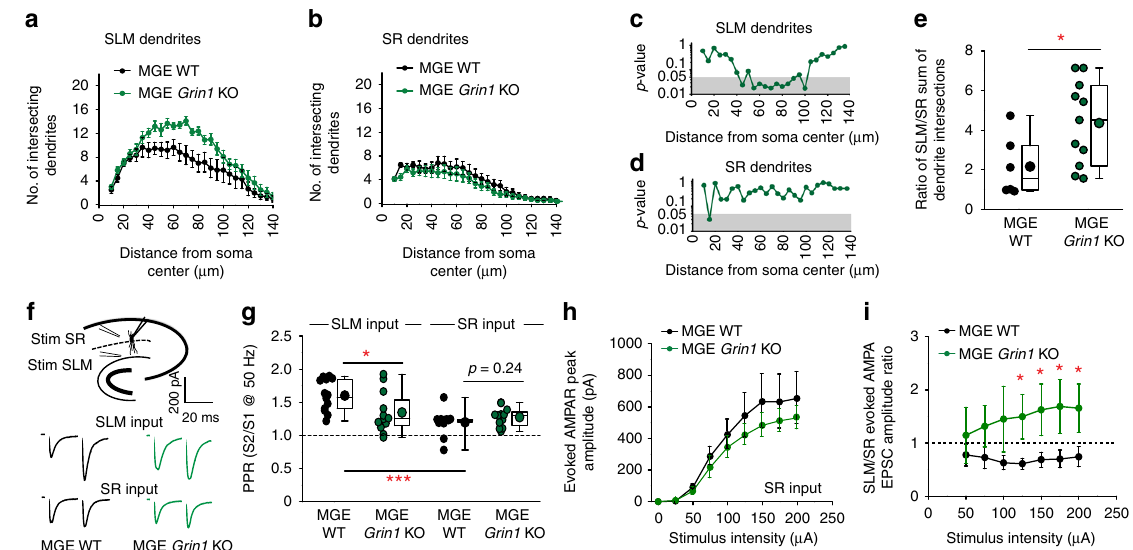
S t i m u l u s i n t en s i t y ( µ A ) Fig. 7 NMDAR hypofunction shifts the relative contributions of AMPA receptor mediated excitatory drive at extra- vs. intra-hippocampal inputs onto individual NGFCs. a , b Sholl analyses plots of total number of intersecting dendrites at each concentric circle (0 – 135 μ m from center of soma every 5 μ m) in WT (black data; n = 6) and Grin1 KO mice ( green data , n = 11) for SLM and SR dendrites in individual MGE NGFCs. Note these data are reanalyzed from the total dendrite Sholl analyses depicted in Fig. 5g. c , d Statistical comparison of the number of intersecting NGFC dendrites at each concentric distance away from the cell soma in WT vs. Grin1 KO mice ( p -values are derived from Mann – Whitney U test). Shaded gray areas denote p < 0.05. ( e ) Ratio of the sum of SLM vs. SR intersecting dendrites (between 40 – 100 μ m away from soma center) in each individual MGE NGFC analyzed in WT ( black circles ; n = 5) and Grin1 KO ( green circles ; n = 11). ( f ) Top panel ; schematic depicting the recording con fi guration and stimulus (stim) electrode arrangement to evoke AMPAR- mediated synaptic input mediated by SR and SLM afferents onto the same NGFC. Bottom panel ; single trace examples of paired pulse ratio (PPR) at 50 Hz of SLM and SR inputs onto an individual NGFC in WT ( black traces ) and Grin1 KO ( green traces ) mice. ( g ) Pooled data of PPR in P16-21 WT ( black circles ; n = 13, 12 for SLM and SR input, respectively) and Grin1 KO mice ( green circles ; n = 12, 11 for SLM and SR input, respectively). ( h ) Relationship curves of SR evoked AMPAR-mediated EPSC amplitude vs. stimulus strength onto MGE NGFCs in WT ( black data ; n = 6) and Grin1 KO mice ( green data ; n = 7). ( i ) Ratio of the SLM vs. SR evoked maximal AMPAR-mediated EPSC amplitude vs. stimulus strength onto individual MGE NGFCs in WT ( black data ; n = 6) and Grin1 KO mice ( green data ; n = 7). Mann – Whitney U -tests were used for all comparisons (** p < 0.01, *** p < 0.001). All n values correspond to the number of cells recorded. Construction of box-whisker plots is detailed in Methods